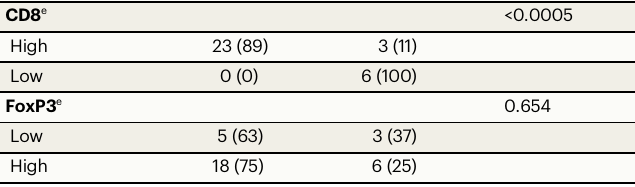
(Fig. 5F). As expected, all of the tumors in Tsp-1 − / − mice had little to no detectable Tsp-1 by IHC (Fig. 5F).